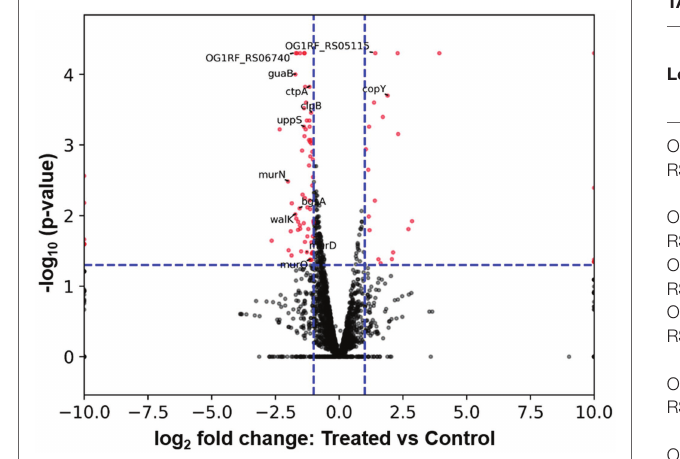
TABLE 3 | Validation of RNA-seq results by RT-qPCR.